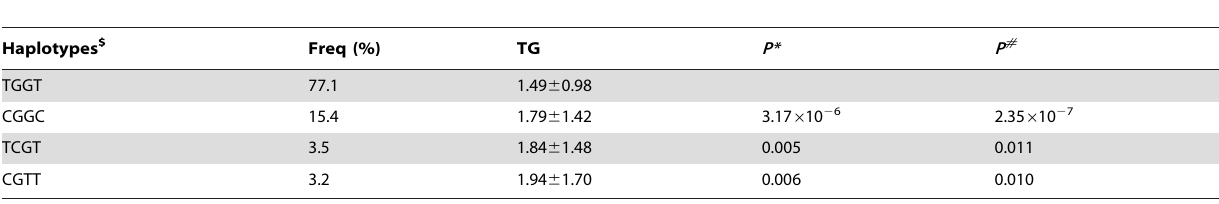
Table 3. Association between the haplotypes in APOA5 and plasma TG levels in the general Uyghur population.